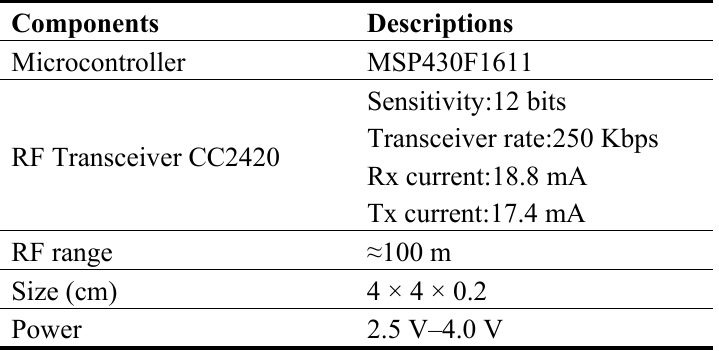
Table 2. Specifications of the sensor node.